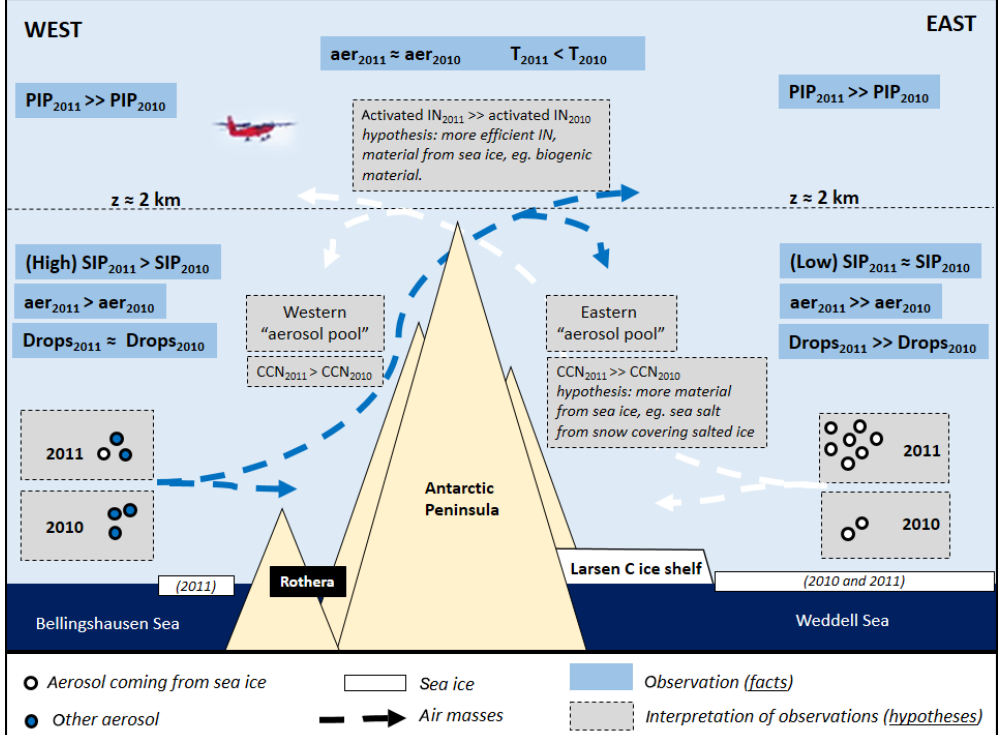
Figure 15. Schematic summarizing main observations from aircraft measurements from both periods of interests (February 2010 and January 2011) and on both sides of the Antarctic Peninsula (blue rectangles), as well as hypotheses (grey-framed rectangles) proposed to explain observations, as presented in the Discussion (Sect. 4). PIP refers to primary ice production, while SIP refers to secondary ice production, as presented in Sect.